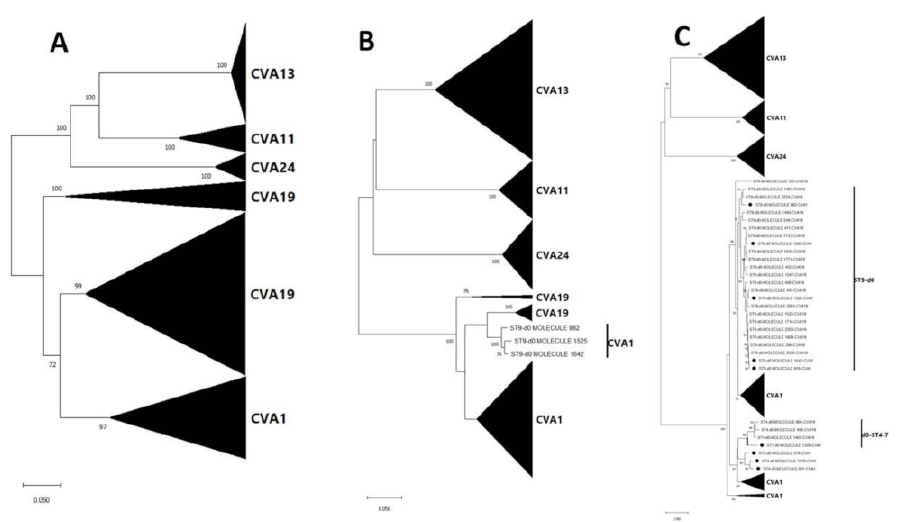
Figure 5. Neighbor joining phylogenetic tree of Enterovirus Cs recovered in this study ( A ) VP4-VP1 [from assay 3a contigs] ( B ) VP1-2C [assay 3b contigs] and ( C ) 2A-2C [from assay 3b contigs] genomic regions. The phylogenetic trees are based on an alignment of Enterovirus C contigs recovered from assay 3a and 3b (LRISW) in this study. In Figure 5C, the CVA1 contigs that do not cluster with other CVA1s are indicated with black circles. Bootstrap support is shown if >50. Abbreviation: ST = site. Collapsed taxa denote all contigs that belong to the same EV type.